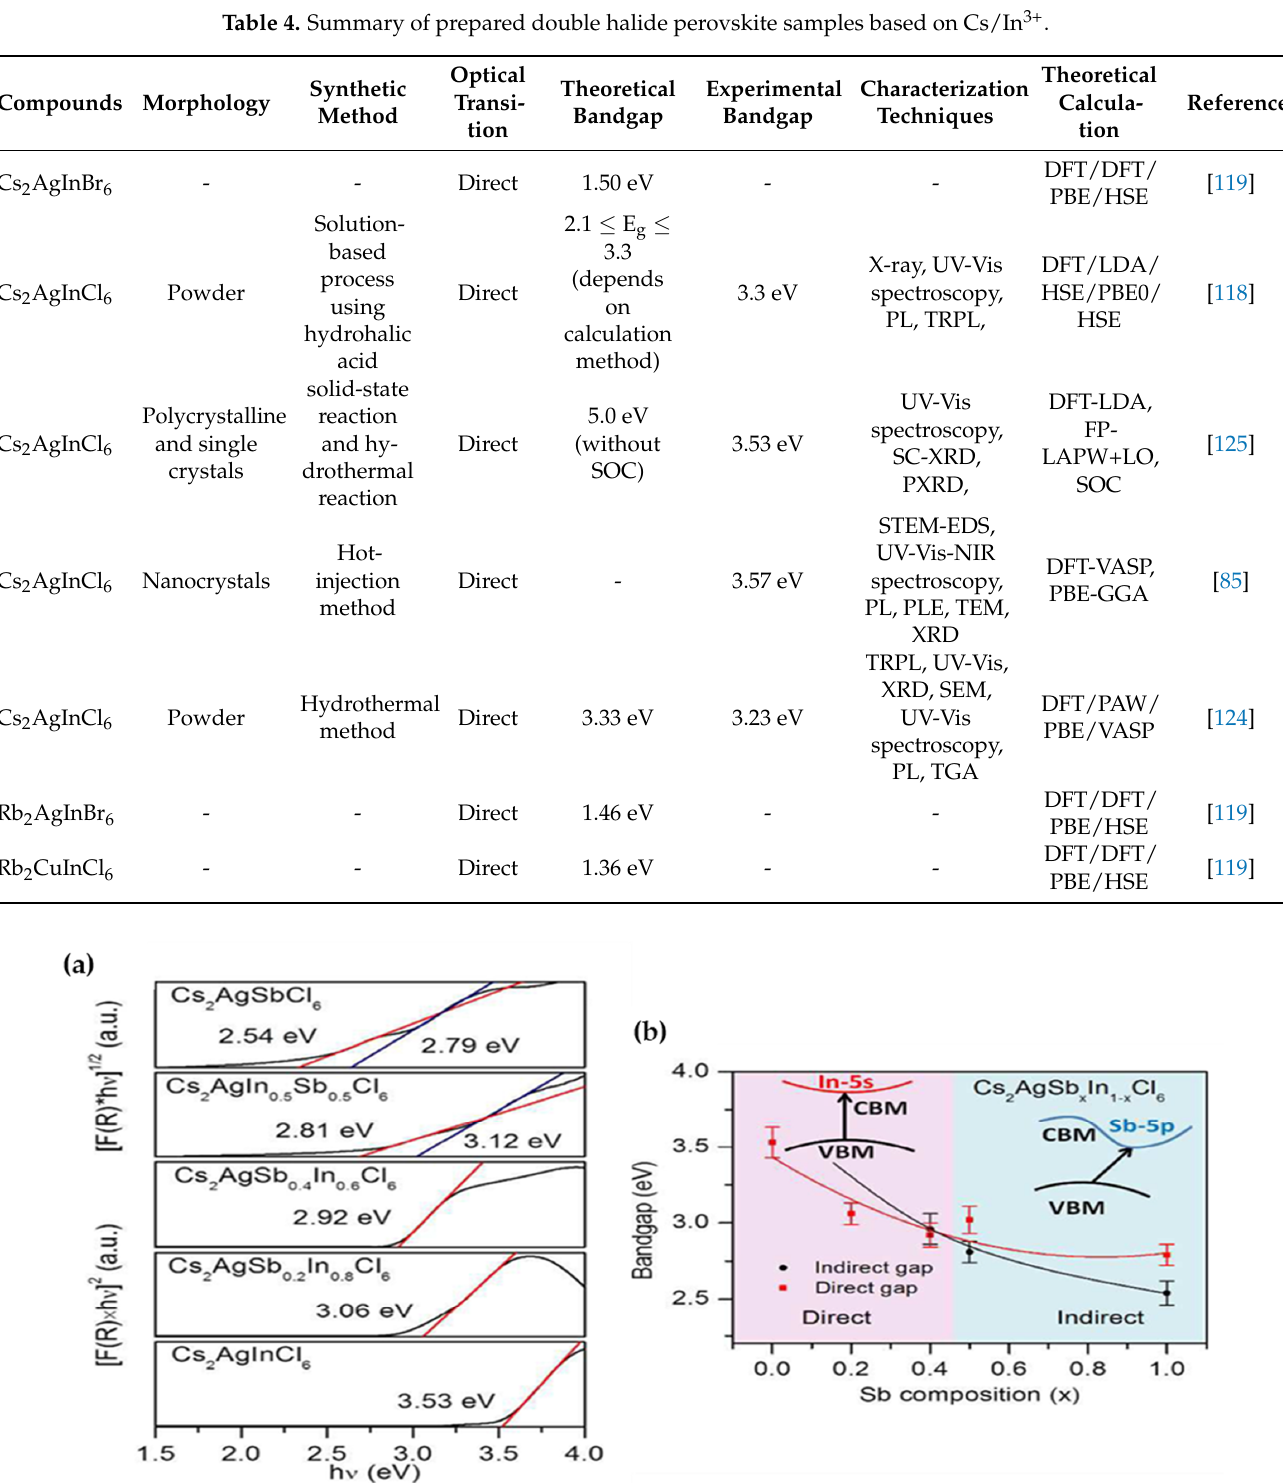
Figure 19. ( a ) Tauc plots for Cs 2 AgSbCl 6 , Cs 2 AgSb 0 . 5 In 0 . 5 Cl 6 , Cs 2 AgSb 0.4 In 0.6 Cl 6 , Cs 2 AgSb 0.2 In 0.8 Cl 6 and Cs 2 AgInCl 6 . The plots indicate the characteristics of an indirect bandgap for Cs 2 AgSbCl 6 , a direct bandgap for Cs 2 AgInCl 6 and a transition from indirect to direct bandgap of Cs 2 AgSb x In 1−x Cl 6 at x = 0.4; ( b ) Phase diagram of Cs 2 AgSb x Ag 1−x Cl 6 showing the bandgap trend as a function of Sb composition and a crossover from indirect to direct optical absorption in a solid solution at x = 0.4. Reproduced with permission from [125]. Copyright 2017, Royal Society of Chemistry.